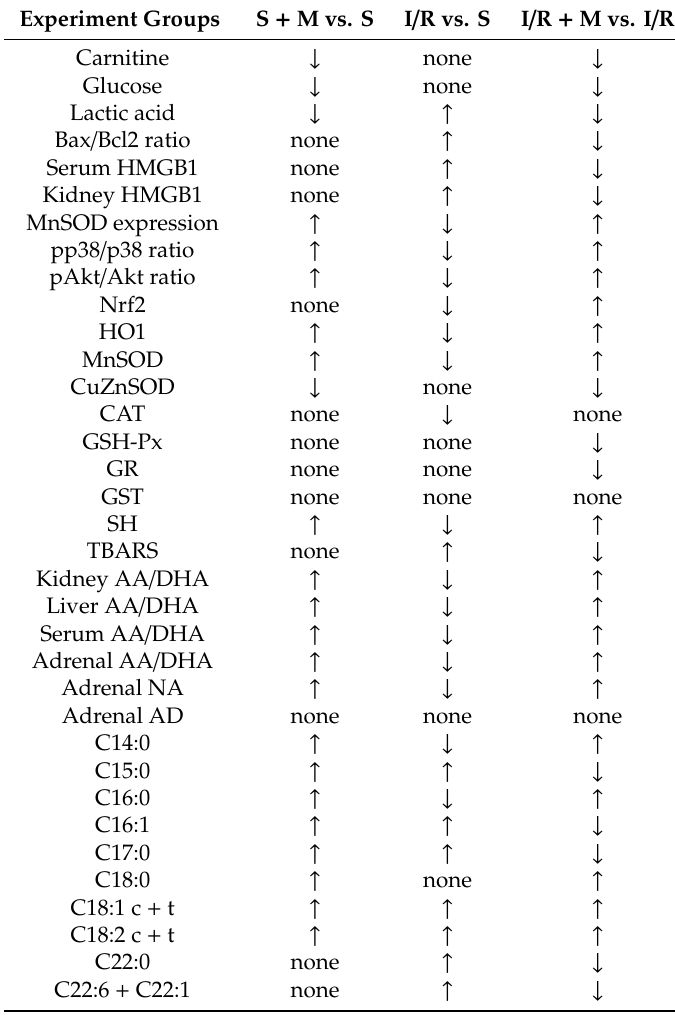
Table 5. Summarized e ff ects of meldonium and I / R on the kidney carnitine, glucose, and lactic acid concentration; the protein expression levels of serum HMGB1 and kidney MnSOD; Bax, Bcl-2, HMGB1, Nrf2, HO-1, and total and phosphorylated p38 / Akt; the kidney activities of copper-zinc superoxide dismutase (CuZnSOD), manganese superoxide dismutase (MnSOD), catalase (CAT), glutathione peroxidase (GSH-Px), glutathione reductase (GR), and glutathione S-transferase (GST); the kidney concentrations of sulfhydryl groups (SH) and lipid peroxides (TBARS); the serum, liver, adrenal gland, and kidney ascorbic / dehydroascorbic acid ratio (AA / DHA); the adrenal noradrenaline (NA) and adrenaline (AD) content; and the kidney fatty acids concentration. Group categories abbreviations: S—sham operated rat group; S + M—sham operated + meldonium rat group; I / R—ischemia / reperfusion rat group; I / R + M—ischemia / reperfusion + meldonium rat group. Up arrow — an increase;